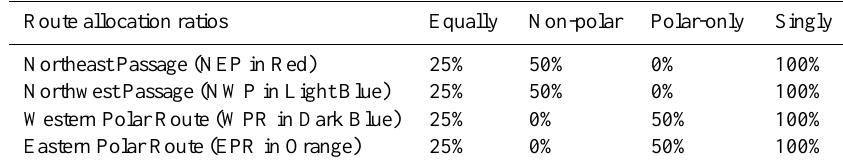
Table 11. Flexibility in diversion route allocation scenarios.